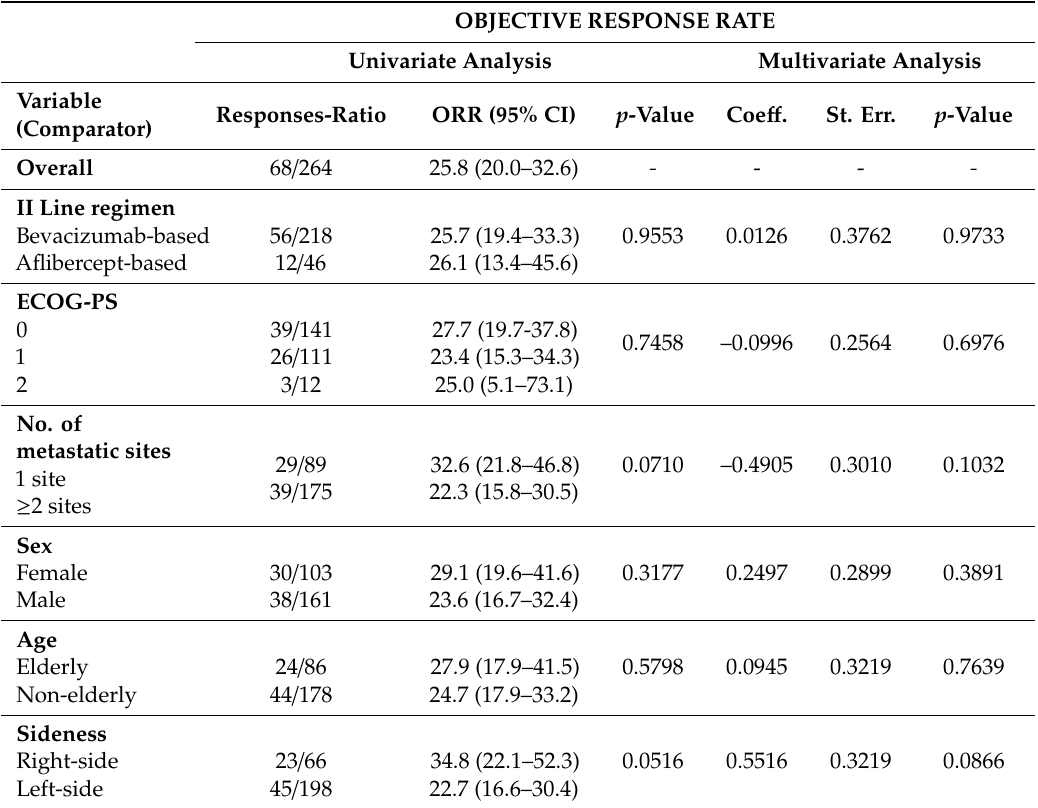
Table 2. Univariate and multivariate analysis for objective response